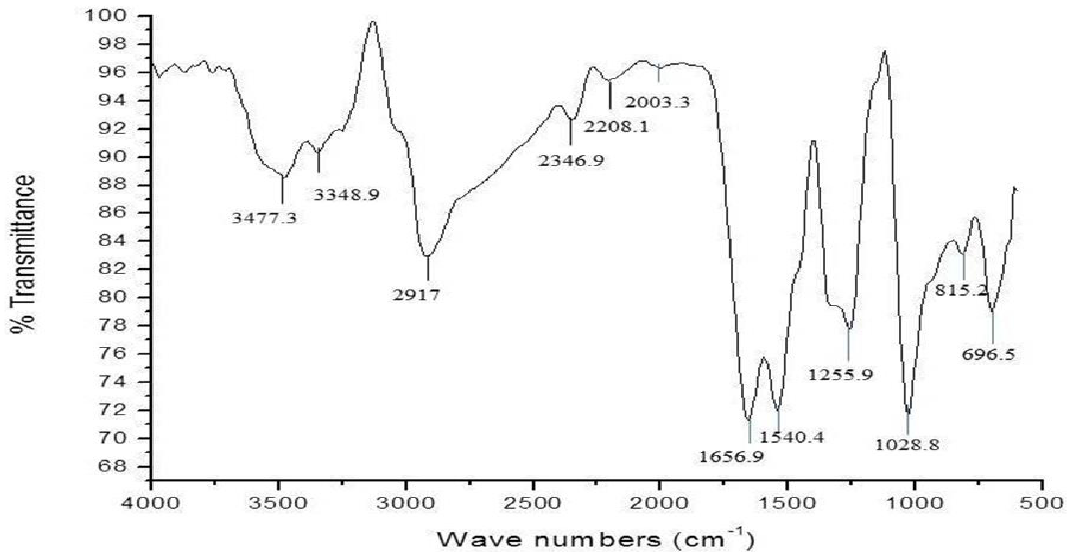
Fig. 6. The image represents the presence of functional groups on the surface of silver nanoparticles